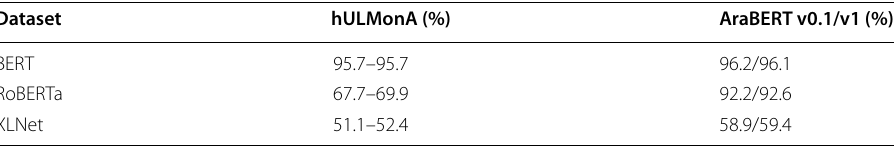
Table 2 Comparison between hULMonA and AraBERT [29,